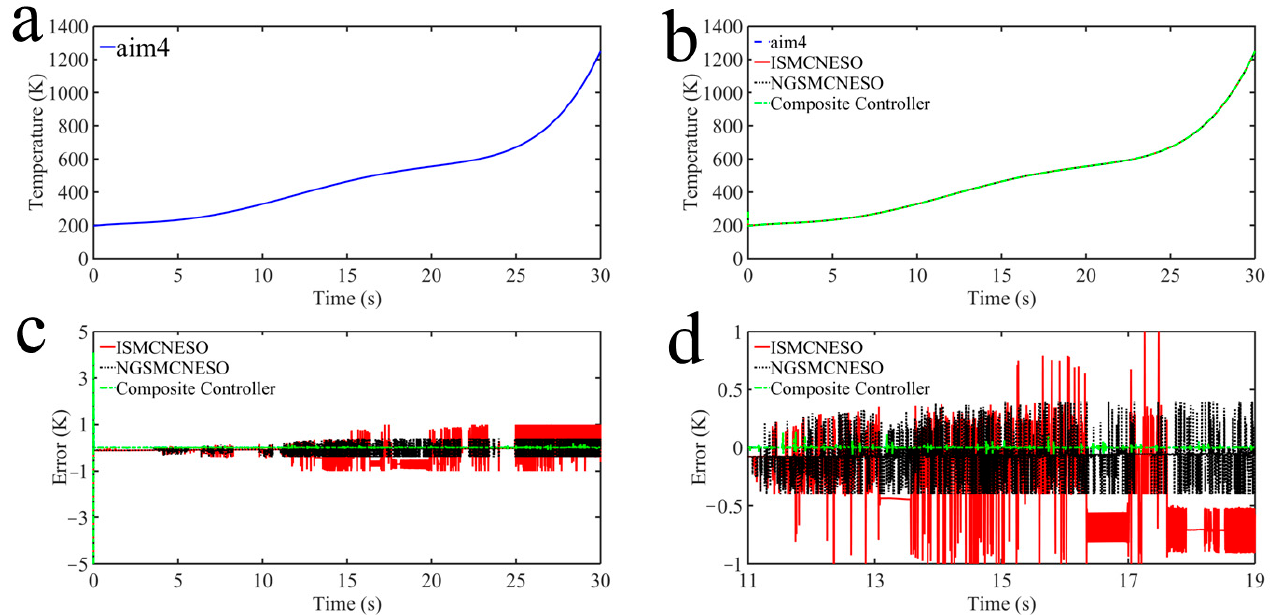
Figure 17. Simulation results: ( a ) the fitting curve of the reference temperature trajectory from Wall 1_5 mm; ( b ) the reference temperature tracking performance among ISMCNESO controller, NGSMCNESO controller, composite controller; ( c ) the tracking errors; ( d ) their partial enlarged figures in details.